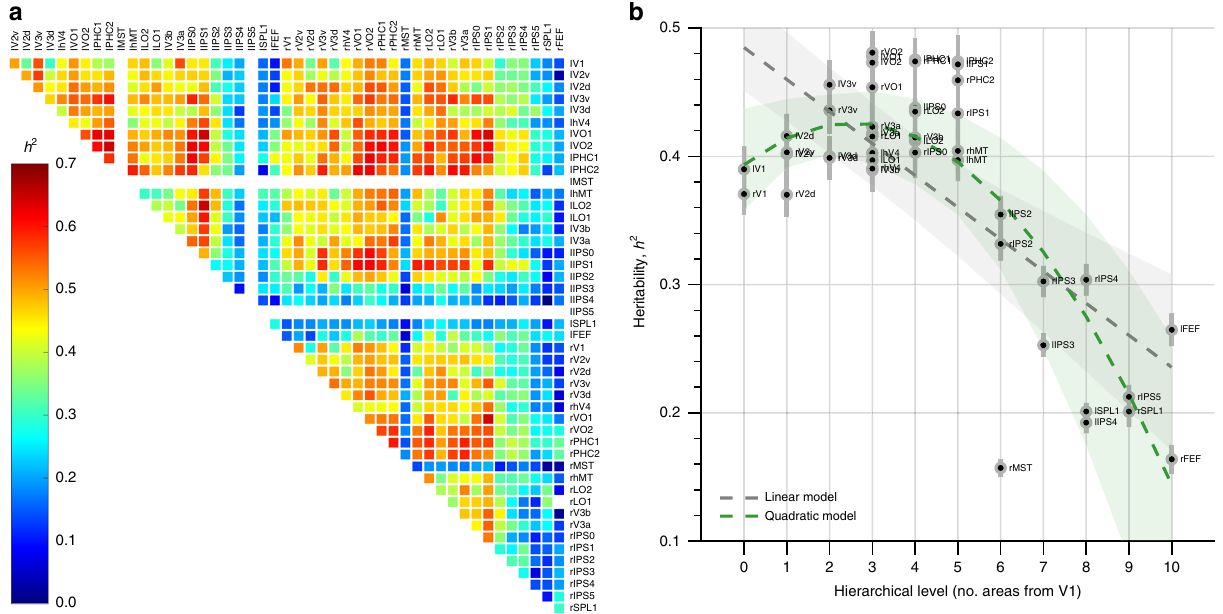
Fig. 1 Heritability of functional connectivity across human visual cortex. a Heritability estimates for all signi fi cant ( p < 0.05, FDR corrected) functional connections. Visual area names are abbreviated according to Wang et al. (2015). b Average heritability of functional connectivity as a function of hierarchical level. Gray error-bars indicate the SEM. Dashed gray and green lines and similarly colored shaded areas indicate linear and quadratic model fi ts and the bootstrapped 95% con fi dence intervals, respectively. Source data are provided as a Source Data fi